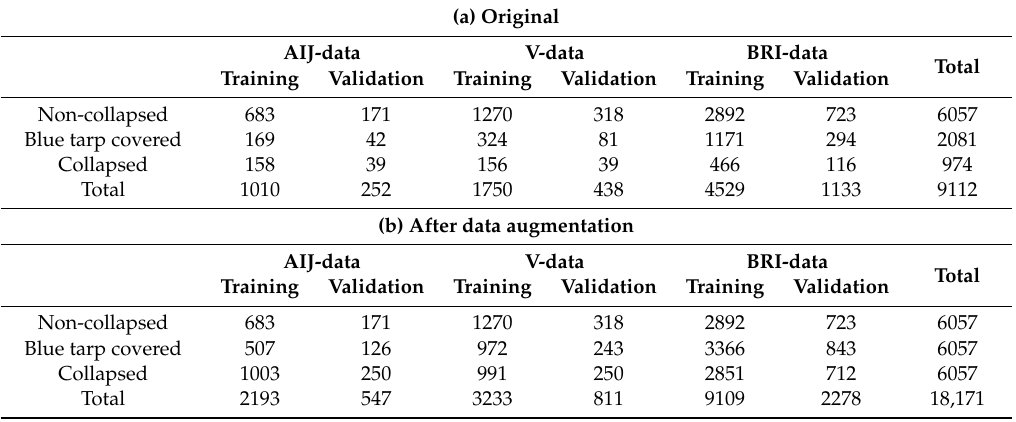
Table 4. ( a ) Numbers of the original training and validation data. ( b ) Numbers of the training and validation data after the data